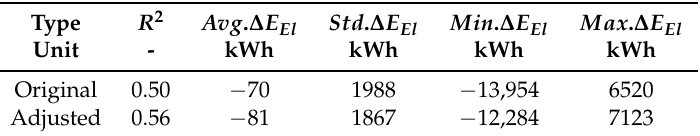
Table 5. Results before and after the adjustments on the test data using logistic regression with C = 1. The chosen logistic regression classifier ensemble was the one that, to the highest extent, reduced the standard deviation of error and increased R 2 . (See Appendix A) C for the results from the logistic regression classifier ensembles with the other C -values.